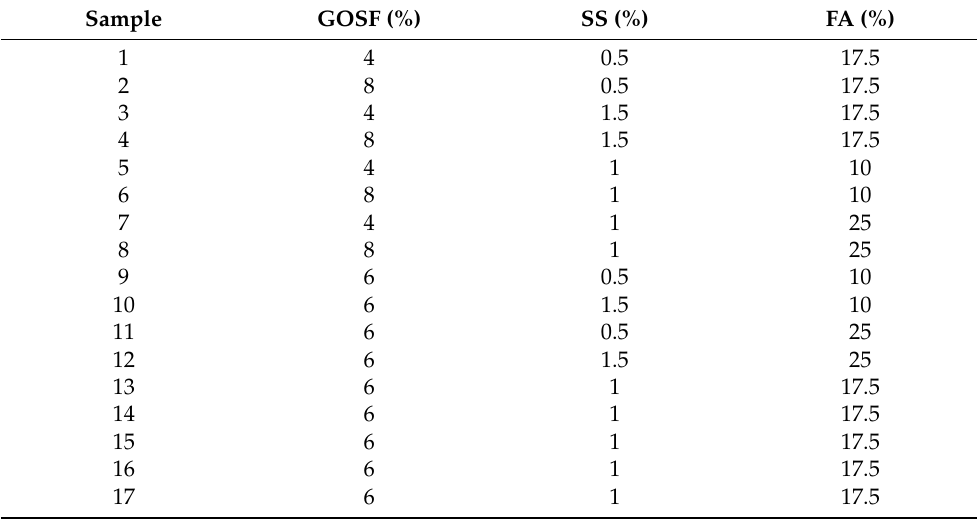
Table 3. The dosages of different materials in experiment